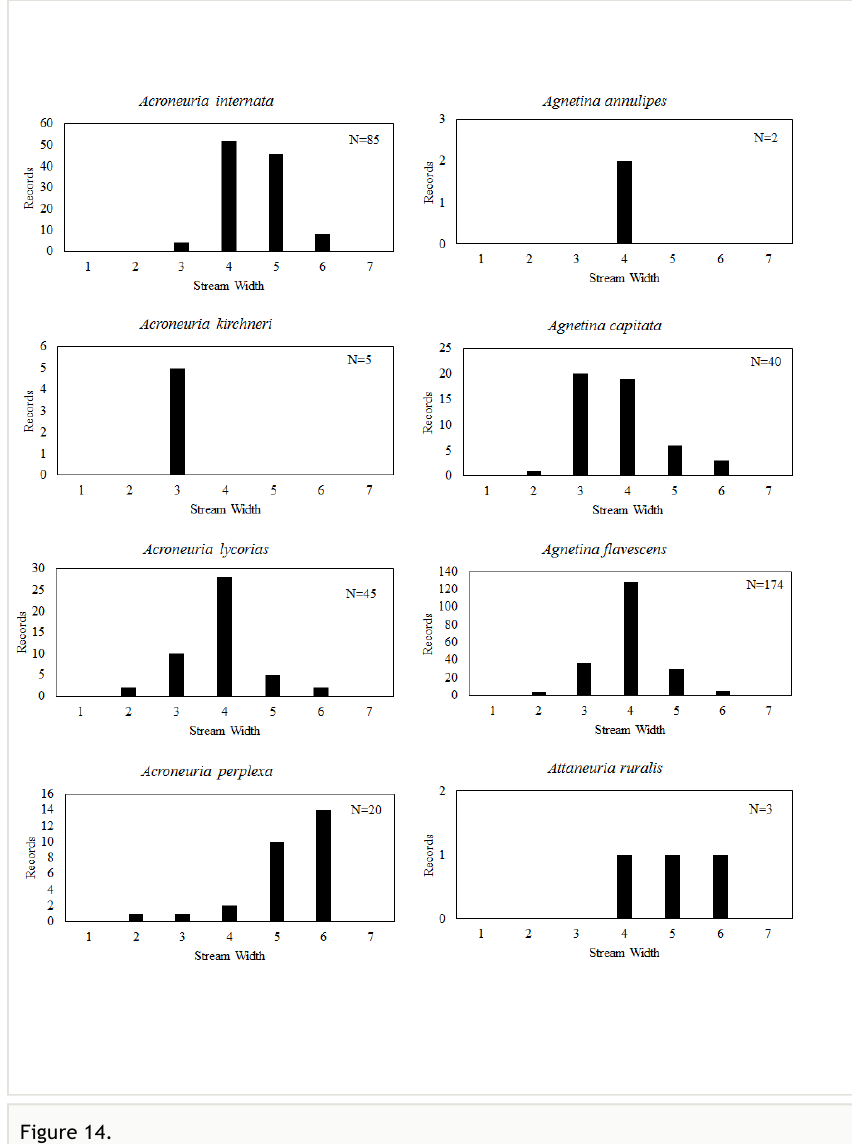
Stream width categories occupied by Perlidae species in Ohio.